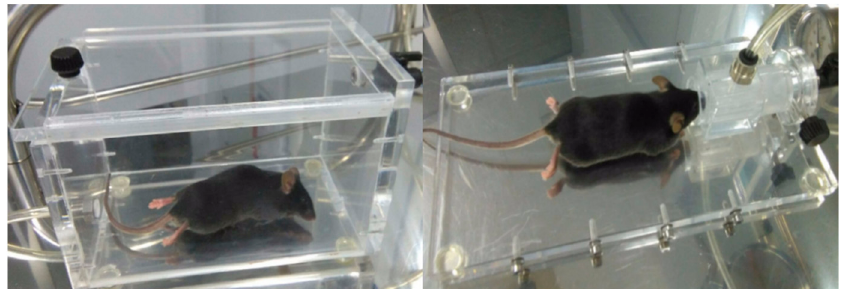
Figure 1. Pictures of the anesthetic induction. The mouse was anesthetized into an induction chamber (left panel). Then, the animal was placed on a tray with its snout into a supplying line of anesthesia (right panel) until the measuring process ended.